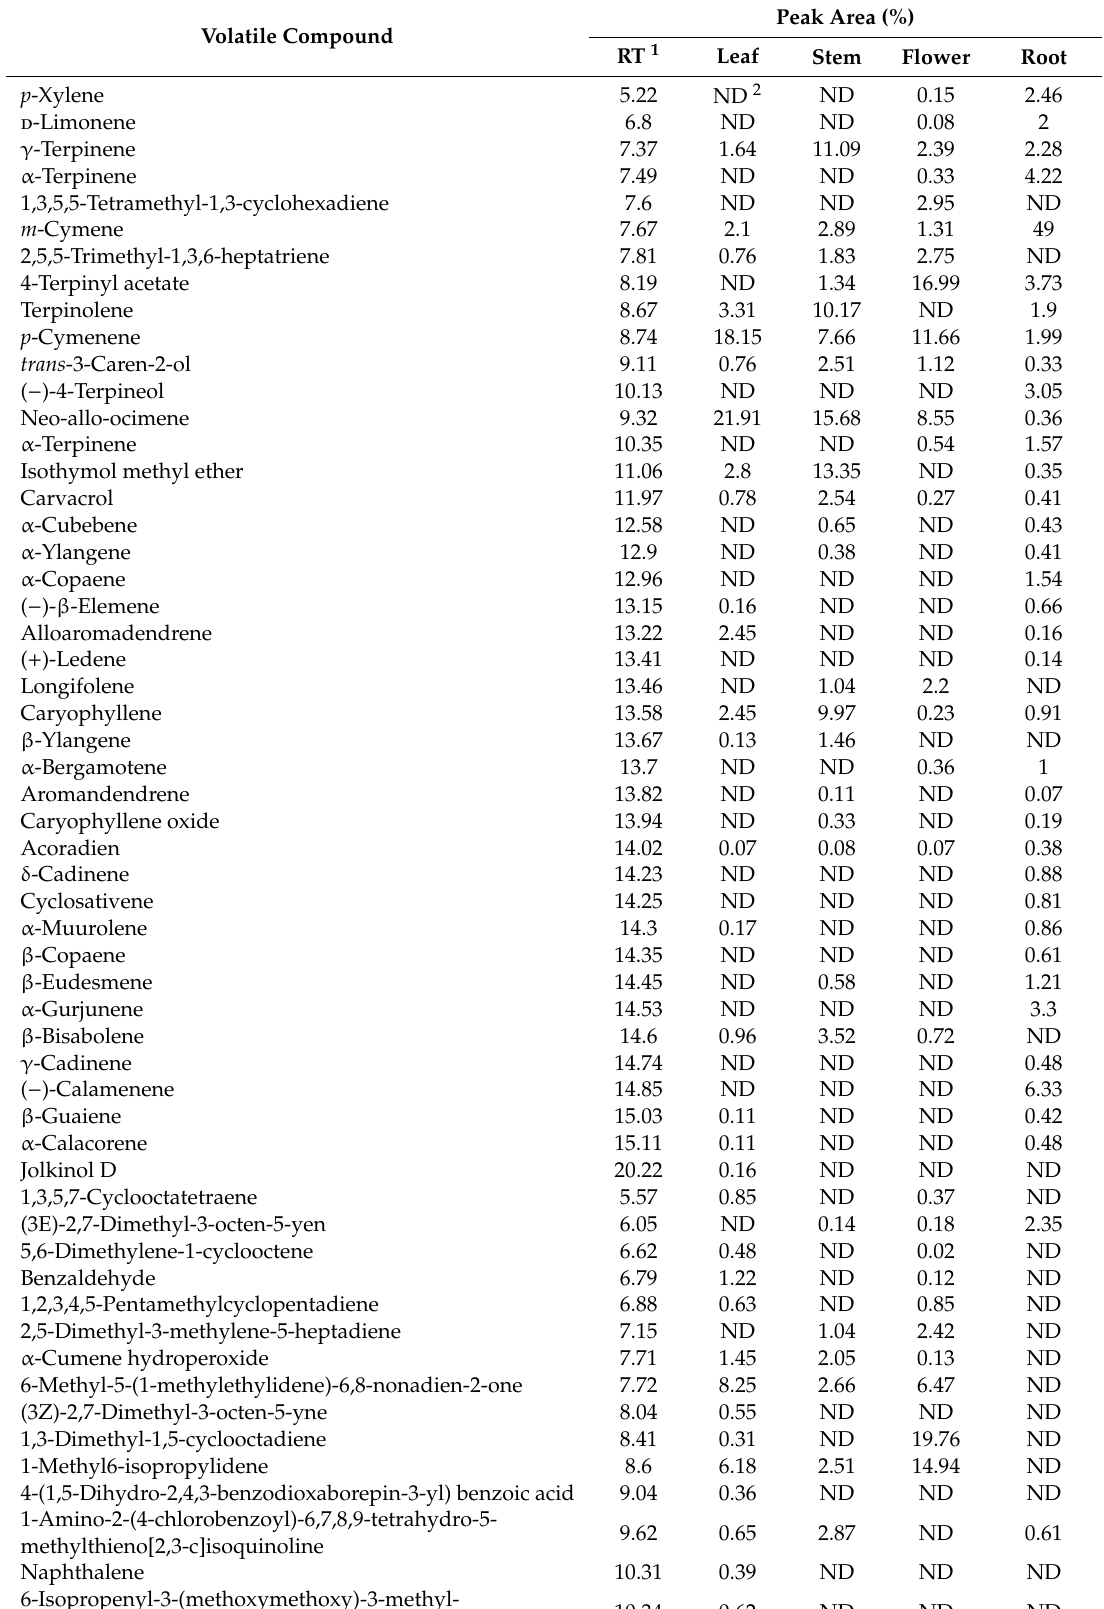
Table 1. Compounds identified in the di ff erent organs of Lavandula pubescens using gas chromatography- mass spectrometry (GC-MS). Volatile Compound